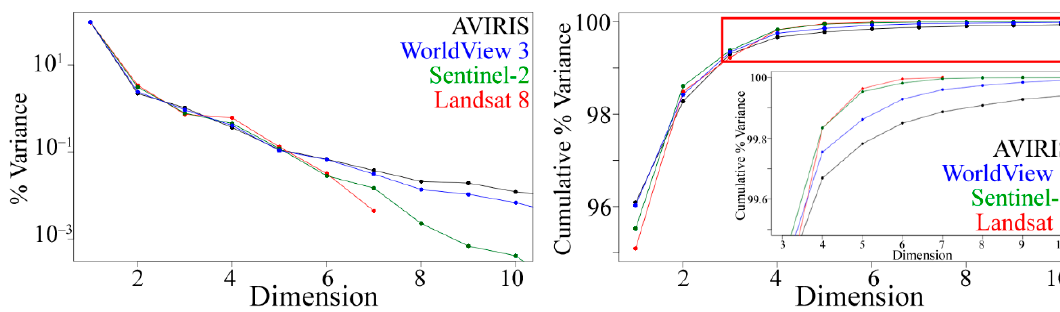
Figure A1. Partition of Variance. Variance present in individual low-order dimensions ( left ) and cumulative variance ( right ) are shown. Of the sensors, the full resolution AVIRIS data (black) is observed to contain the greatest fraction of variance at high (e.g., > 5) dimensions, consistent with greater data dimensionality and higher information content than the multispectral sensors. Sentinel-2 and Landsat 8 (green and red) demonstrate similar variance partitioning. Interestingly, WorldView 3 more closely mimics AVIRIS than the other multispectral sensors, presumably because of its SWIR bands.